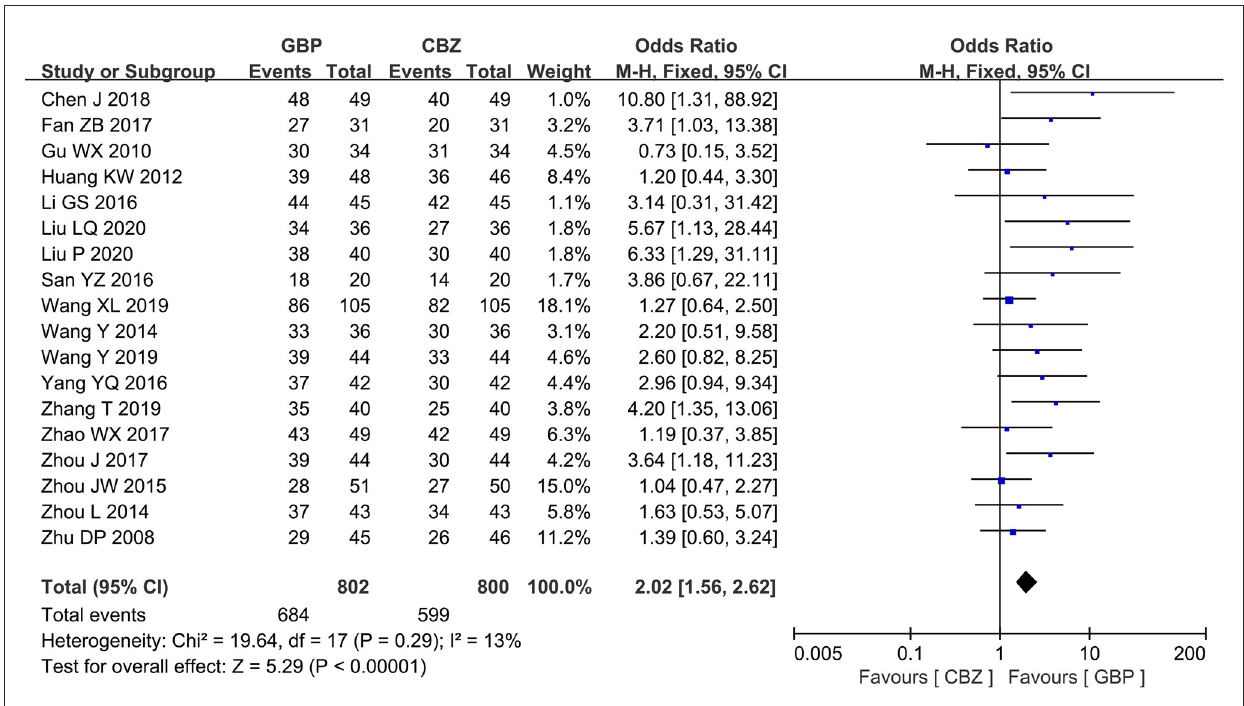
FIGURE3 Forest plot of GBP vs. CBZ: effective rate. GBP, gabapentin; CBZ, carbamazepine.